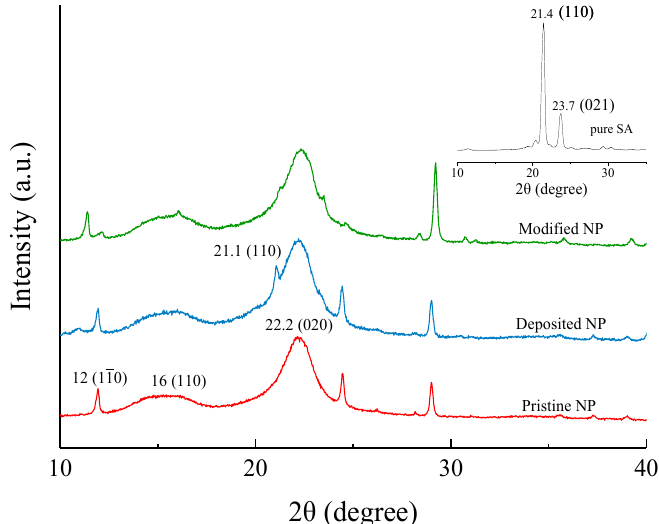
Figure 3. XRD pattern of pristine NP, deposited NP, modified NP and pure SA.